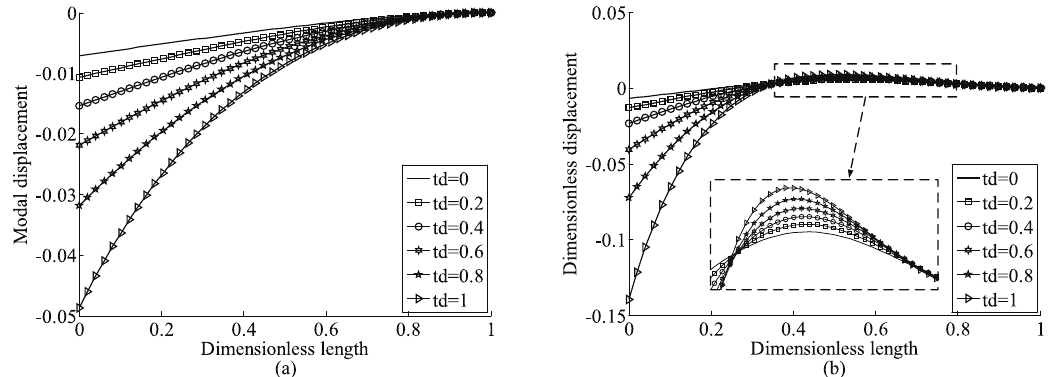
Fig. 10. The variation of first two modal shapes with tapered orders of beams under free-clamped boundary condition: (a) the first modal shapes, (b) the second modal